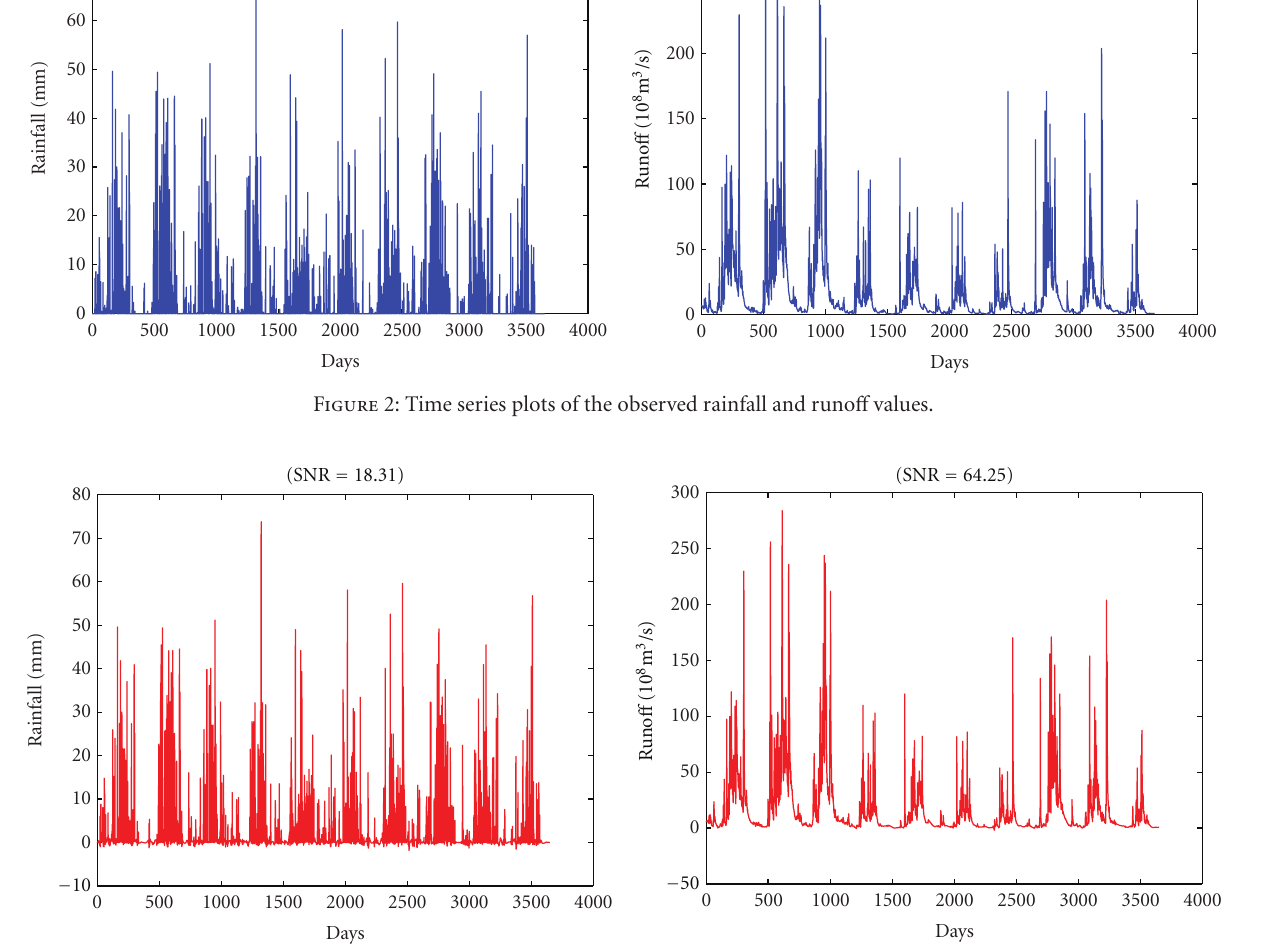
Figure 3: Time series plots of the denoised rainfall and runo ff